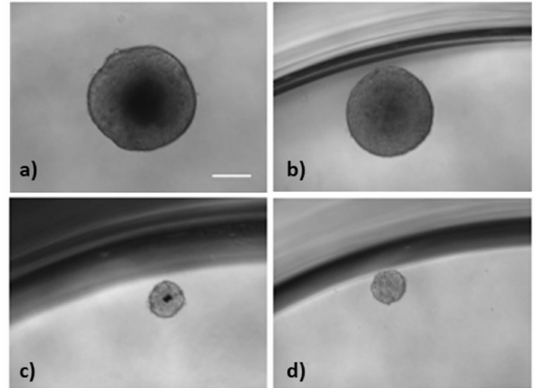
Figure 8. Activity of AuNCs in MCF7 mammospheres. ( a ) Control; ( b ) treated with AuNCs, ( c ) AuNCs-DS-(1), and ( d ) AuNCs-DS-(2), respectively. (1) means 0.08 µ M concentration of the bifunctional complex, whereas (2) reflects treatments with the nanoconjugate at 0.6 µ M. Scale bar 200 µ